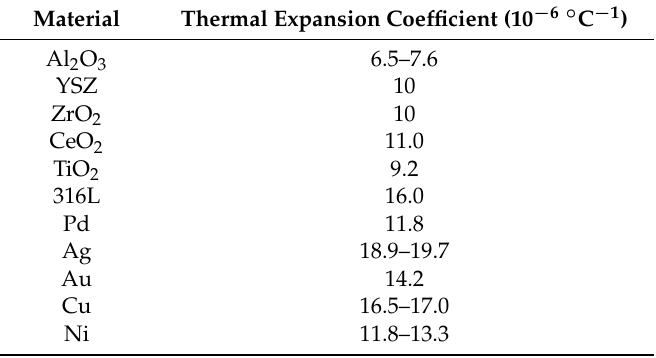
Table 4. Thermal expansion coefficients of some materials used for the preparation of hydrogen selective membranes